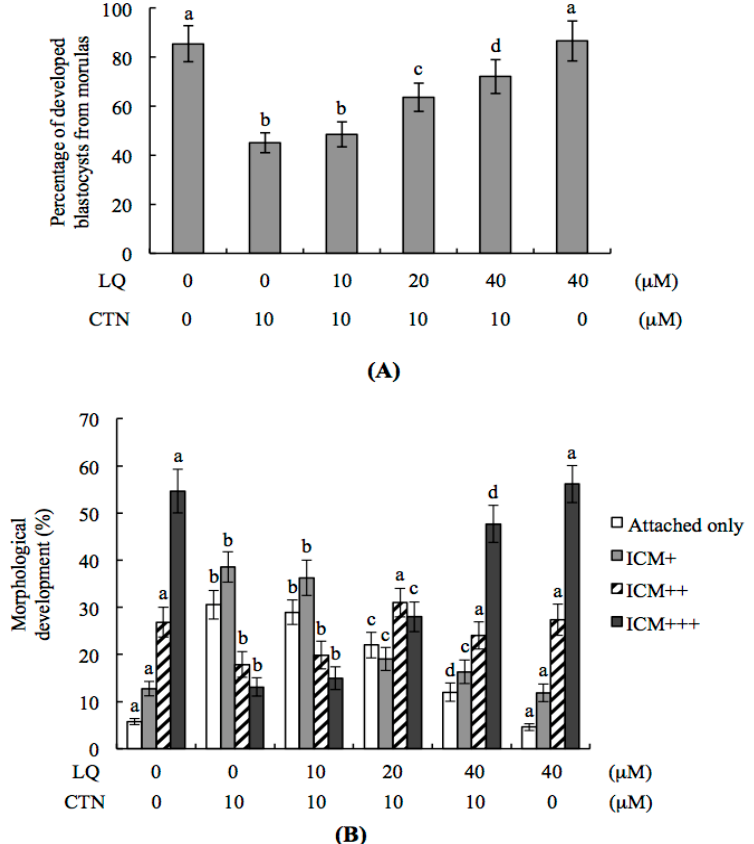
Figure 2. Effect of LQ on in vitro embryonic development of CTN-treated blastocysts. ( A ) Mouse morulae were preincubated with LQ (10–40 μ M). After 1 h, embryos were further treated with or without 10 μ M CTN for 24 h. Morulae were cultured for another 24 h at 37 °C, blastocyst numbers counted and the percentages calculated; ( B ) Mouse blastocysts were pre-incubated with LQ (10–20 μ M) or vehicle for 1 h followed by 10 μ M CTN for a further 24 h. The developmental status of blastocysts was observed in culture on fibronectin-coated dishes for 72 h during post-treatment and used to identify blastocysts attached to fibronectin-coated dishes only (attachment only), classified as ICM+, ICM++, and ICM+++. Morphological assessment was based on the criteria described in Materials and Methods. The total blastocyst number was 150 for each group. Values are presented as means ± SD of five determinations. Different symbols indicate significant differences at p < 0.05.